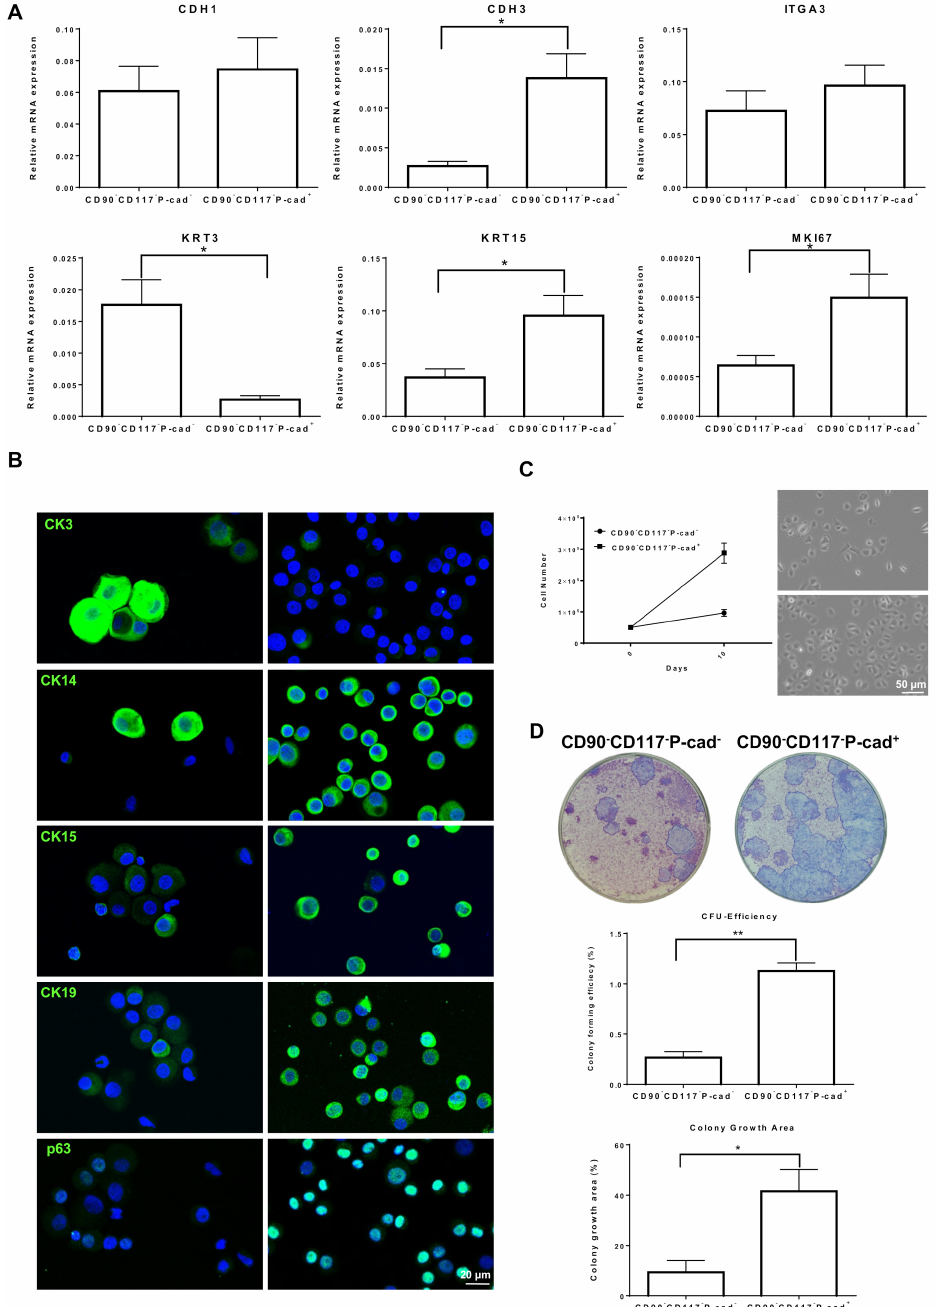
Figure 4. Characterization of P-cadherin + (P-cad + ) limbal epithelial cells: ( A ) Quantitative real-time polymerase chain reaction primer assays confirming the differential expression of limbal progen- itor (Keratin (KRT)15), differentiated marker (KRT3) and proliferative cell marker (Ki-67 (MKI67) and similar expression of epithelial markers (E-cadherin (CDH1), integrin α 3 (ITGA3)) in